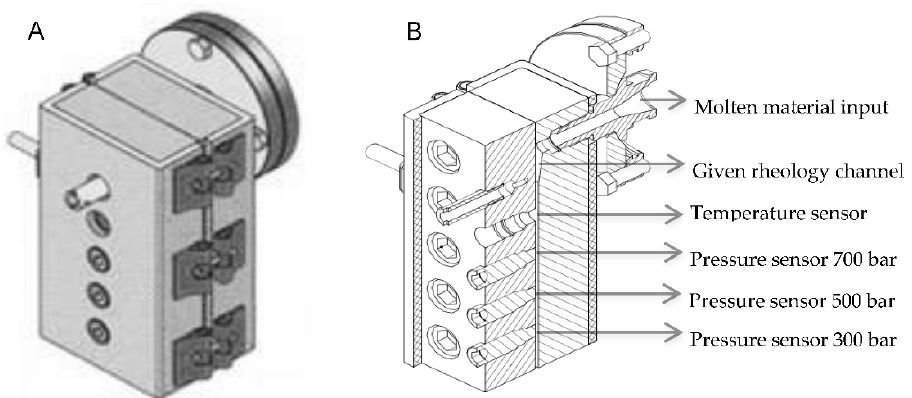
Figure 1. In-line slit die rheometer ( A ). General view ( B ). Longitudinal cut. Source: Adapted from Thermo